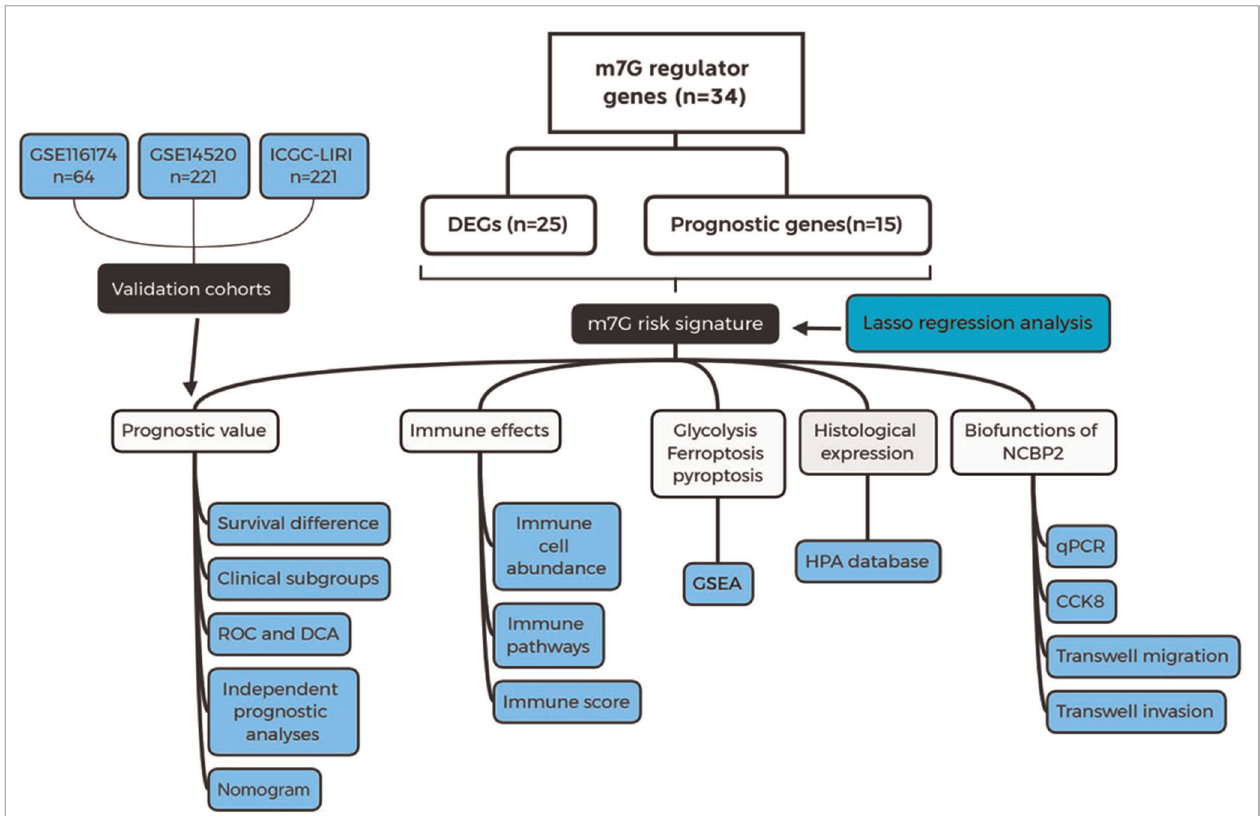
FIGURE 1 | Flow chart of the present study. m7G, N7-methylguanosine; DEGs, differentially expressed genes; ROC, receiver operating characteristic curve; DCA, decision curve analysis; GSEA, gene set enrichment analysis; HPA, Human Protein